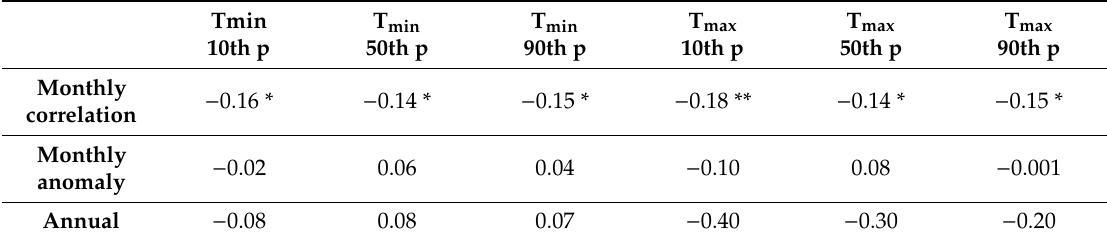
− 0.08 0.08 0.07 − 0.40 −